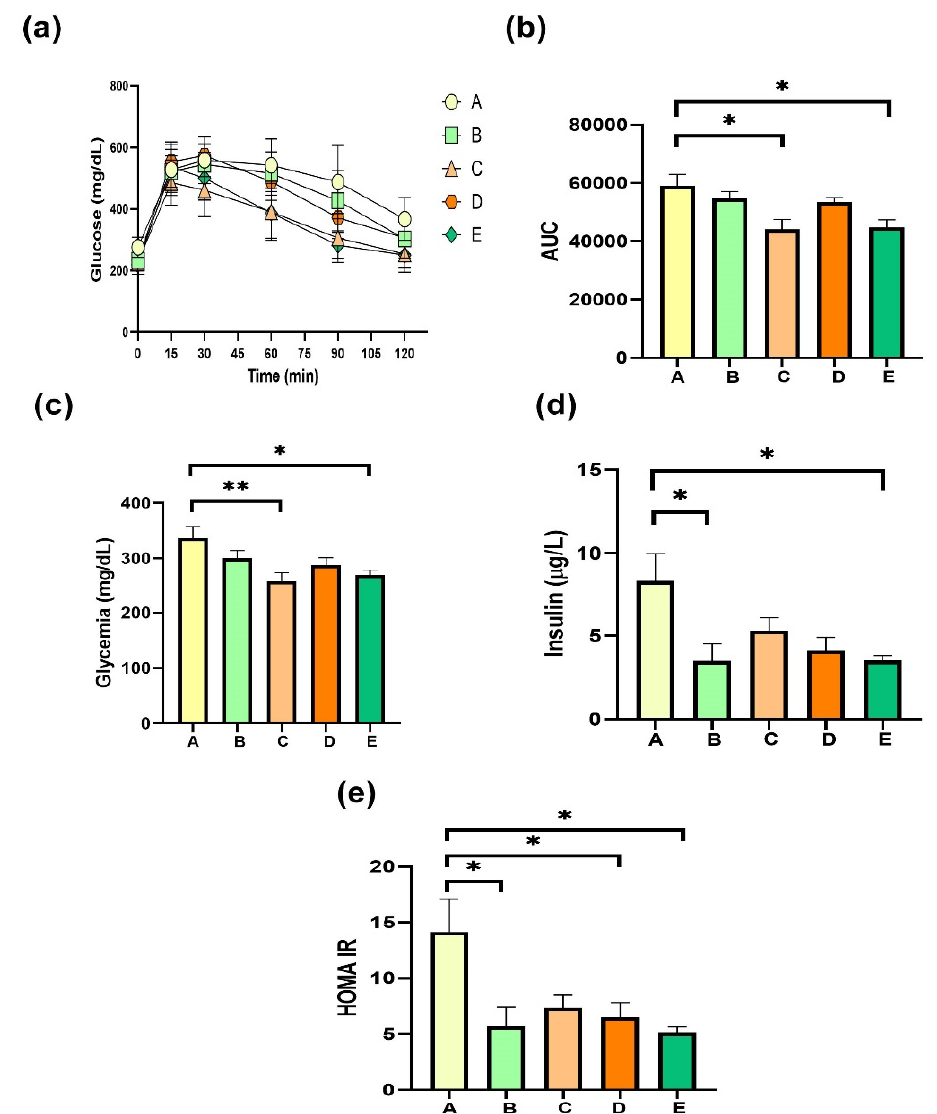
Figure 4. Effects of sPAG treatment on glycemic management in obese mice. ( a ) intraperitoneal glucose tolerance test shows; ( b ) area under curve from ( a ); ( c ) fasting glycemia; ( d ) fasting insulin, and ( e ) homeostatic model assessment for insulin resistance. Treatments were as follows: Group A, sunflower oil; group B, gallic acid; group C, DRCSO; group D, sAG and group E, sPAG. Mice were fasted for 6 h before euthanasia (n = 6–8). Data are expressed as mean ± standard error of the mean (S.E.M.). Statistical differences were determined using one-way ANOVA, followed by Tukey’s post hoc test: * p < 0.05, ** p < 0.01.